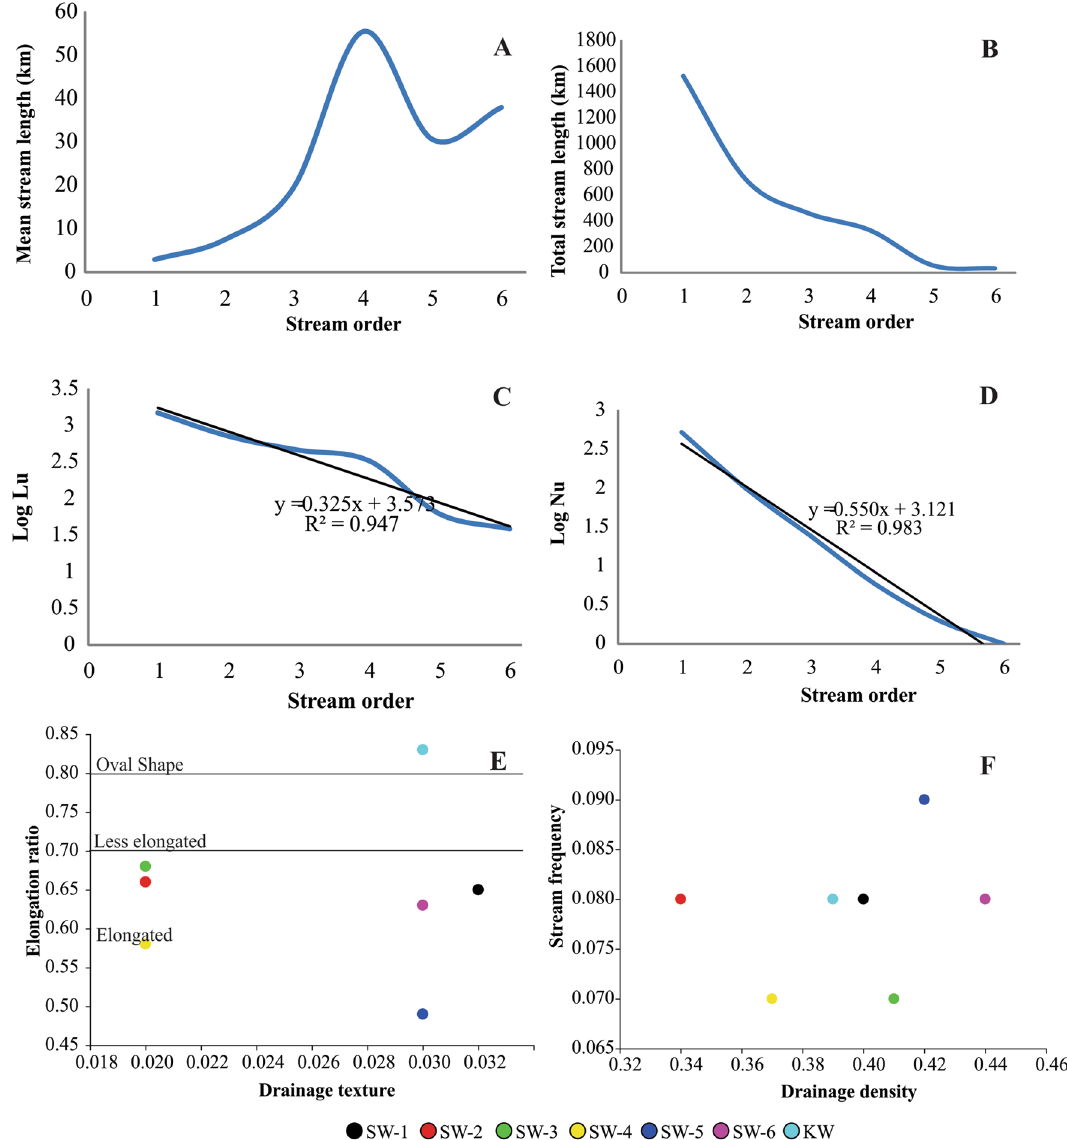
Fig. 4 Bivariate plots of a mean stream length versus stream order, b total stream length versus stream order, c stream length ( L u ) versus stream order ( N u ), d log N u versus stream order ( N u ) (Horton’s first law) and b stream length ( L u ) versus stream number, e elongation